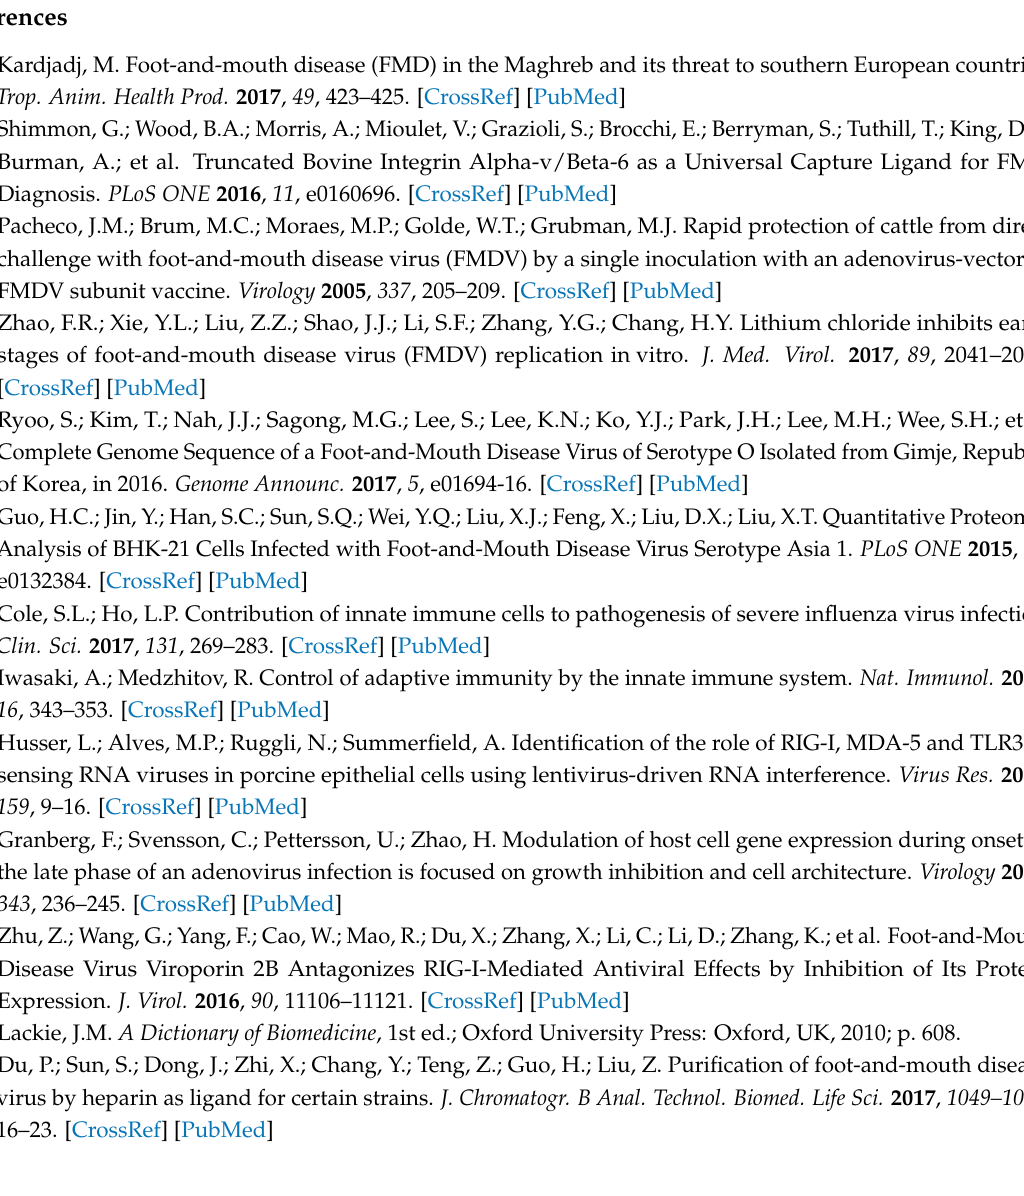
Table S2: Primers for verification of RNA-seq-detected DEGs with RT-qPCR, Table S3: Sample correlation coefficient